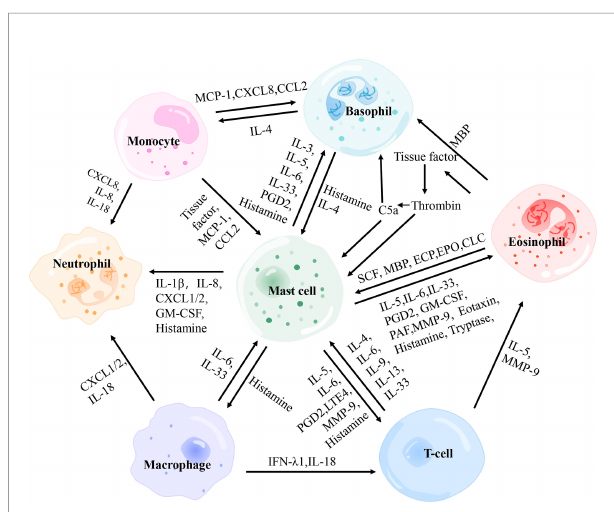
FIGURE 3 | The interactions between main effector cells involved in chronic spontaneous urticaria. PGD2, prostaglandin D2; MBP, major basic protein; MCP-1, monocyte chemotactic and stimulating factor; CCL, C-C motif chemokine ligand; CXCL, C-X-C motif chemokine ligand; SCF, stem cell factor; ECP, eosinophil cationic protein; EPO, eosinophil peroxidase; GM- CSF, granulocyte-macrophage colony-stimulating factor; PAF, platelet- activating factor; MMP-9, matrix metalloproteinase-9; IFN- l 1, interferon- l